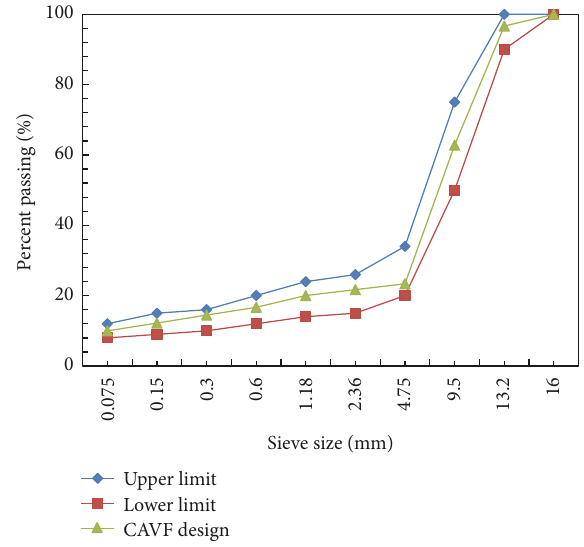
Figure 1: CAVF design gradation for